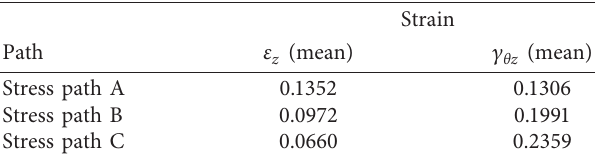
Table 3: Strain results of stress paths A, B, and C.